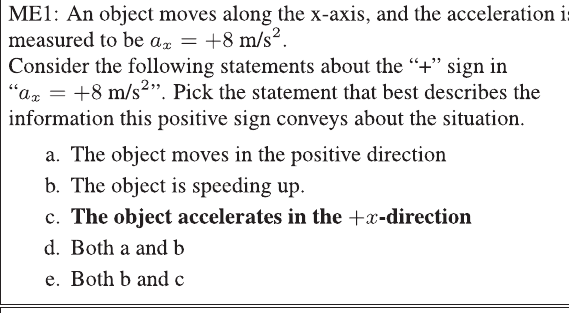
FIG. 3. Percentage of students who answered correctly for positive and negative versions of mechanics items, N ¼ 309 ; the error bars represent the binary standard N neg